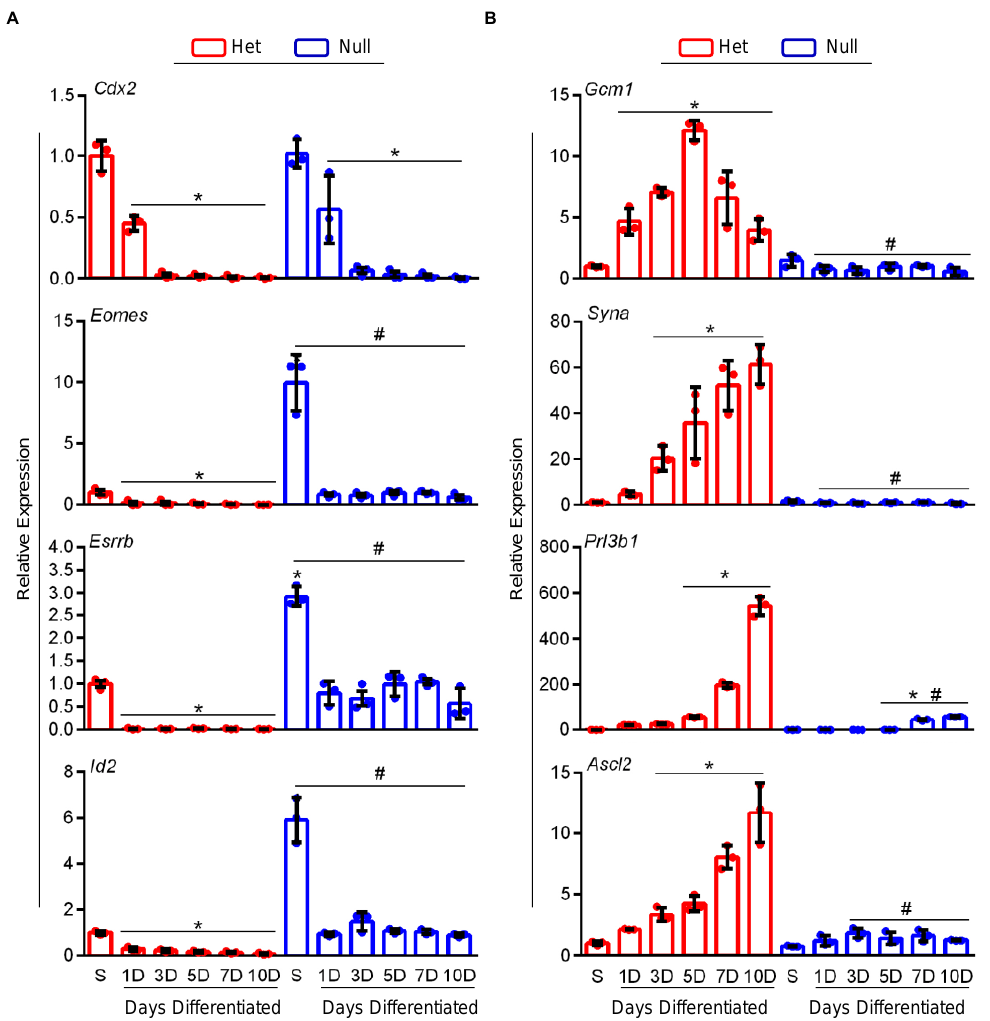
Figure 6. Ovol2 -null TS cells express high levels of stem-related genes and exhibit impaired differentiation potential. Quantitative RT-PCR was used to analyze expression of ( A ) stem ( Cdx2 , Esrrb , Eomes , and Id2 ) and ( B ) differentiation markers ( Gcm1 , Syna , Prl3b1 , and Ascl2 ) in Ovol 2-heterozygote (Het) and null TS cells cultured in stem conditions (S) or up to 10 days in differentiation conditions. Values significantly different from Ovol2 -Het TS cells cultured in stem conditions are represented with an asterisk (*, N = 3, P < 0.05); values significantly different between Ovol2 -Het and null TS cells at each respective time point are indicated with a number sign (#, P < 0.05). Graphs represent means (SD).